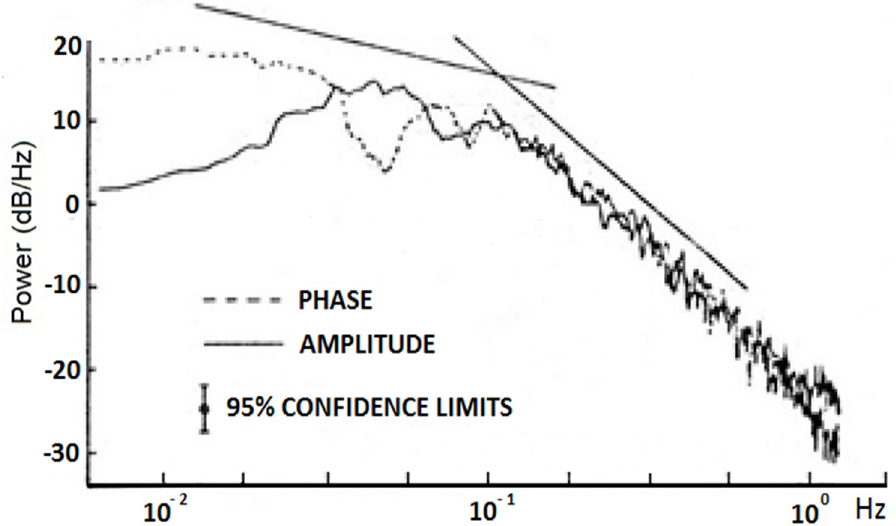
Figure 3. Smoothed power spectra of filtered amplitude and phase scintillations on a 140 MHz signal transmitted from the geostationary satellite ATS-6 and recorded at the low-latitude station Ootacamund during a 15 min interval starting at 21:13 h local time on 24 October 1975. The two straight lines are parallel to the linear fits to the spectra of phase fluctuations over different frequency ranges, which for weak scintillations have a one-to-one relationship with the scale sizes of the corresponding irregularities.